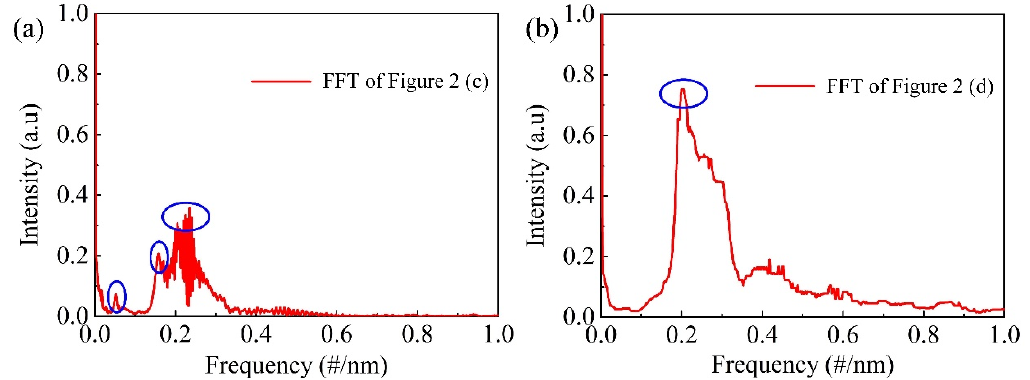
Figure 3. Frequency spectra of the interference spectra of ( a ) S 3 and ( b ) S 4 by Fast Fourier-Transform (FFT).